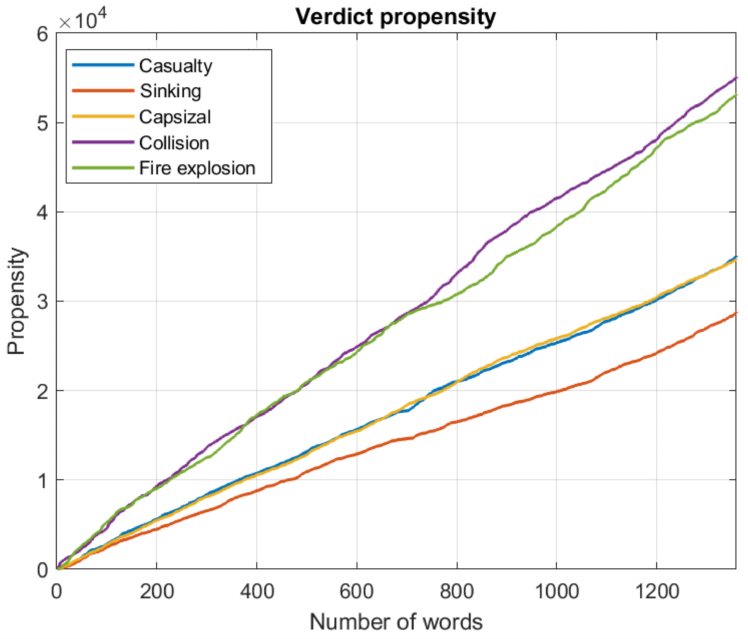
Figure 7. Verdict propensity of “complex collision” accident